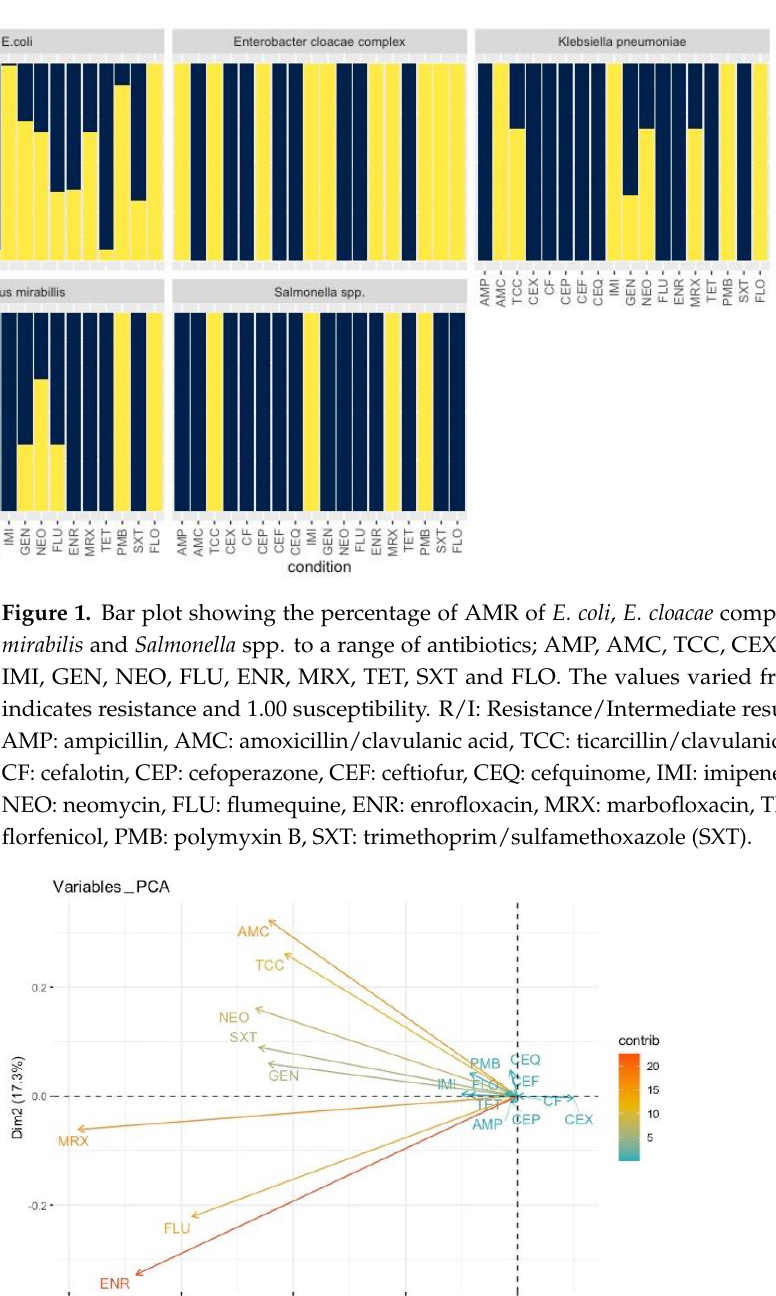
Figure 3. Box and whisker plot showing the prevalence of AMR ( y axis) of ESBL-producing E. coli , E. cloacae complex, K. pneumoniae , P. mirabilis and Salmonella spp. ( x -axis). The bold line shows the median value, while the length of the box represents the interquartile range.